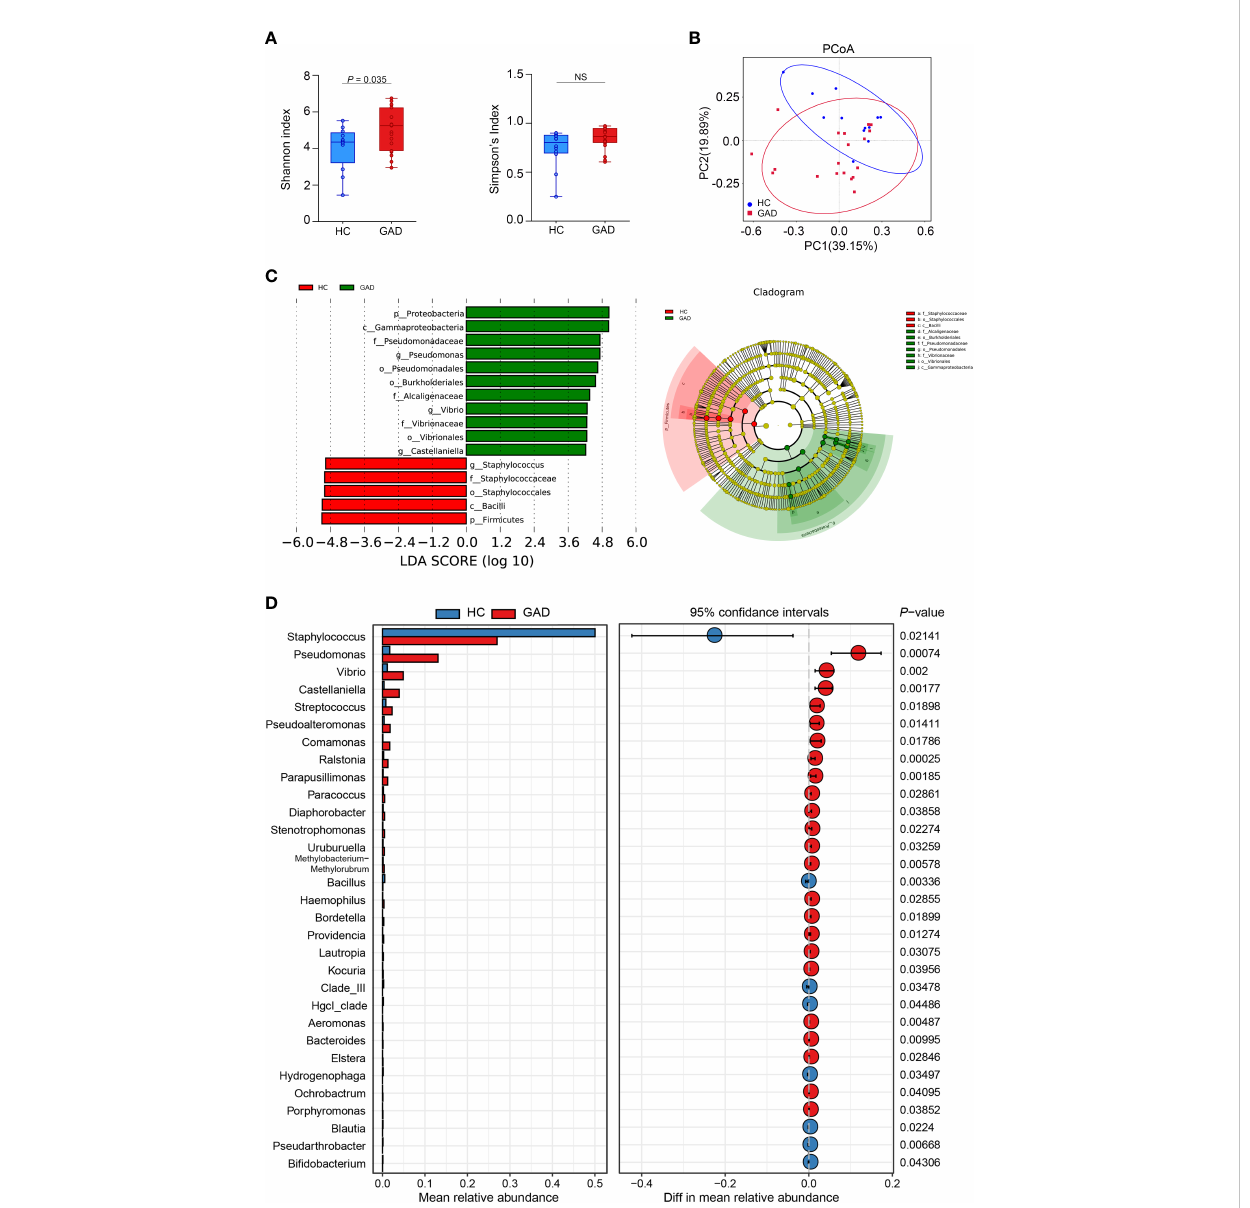
FIGURE 1 Alteration of ear canal microbiota in GAD patients using 16S rRNA gene amplicon sequencing. (A) Boxplots of a -diversity as measured by Shannon diversity and Simpson diversity. Elements show the median, minimum and maximum values. (B) Principal coordinate analysis of all samples based